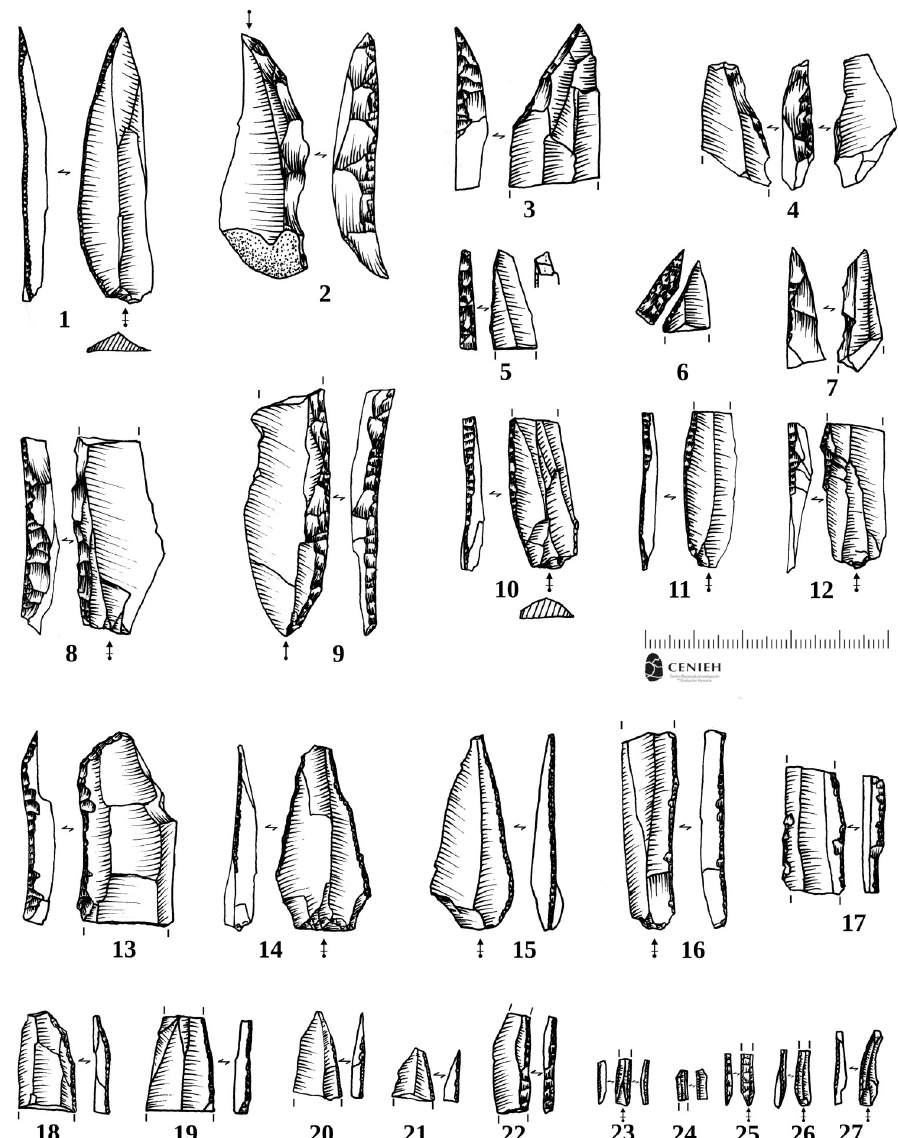
Fig 6. Chaˆtelperronian retouched tools. Selected retouched tools from US4b. 1) Complete thin Chaˆtelperronian point; 2) Thick Chaˆtelperronian point, with the point made in the proximal part; 3) Distal fragment of wide Chaˆtelperronian point; 4–7) Distal fragments of Chaˆtelperronian points: #5 exhibits axial diagnostic impact fracture; 8–12) Proximal fragments of backed blades, possible Chaˆtelperronian points; 10–12) Proximal fragments of Chaˆtelperronian points; 13) Distal fragment of backed blade; 14–15) Marginally backed points; 16–18) Fragments of marginally backed blades; 19–21) Distal fragments of marginally backed points; 22–26) Backed bladelets: #24 presents typical Dufour ventral semi-abrupt retouch. Drawings made by Joseba